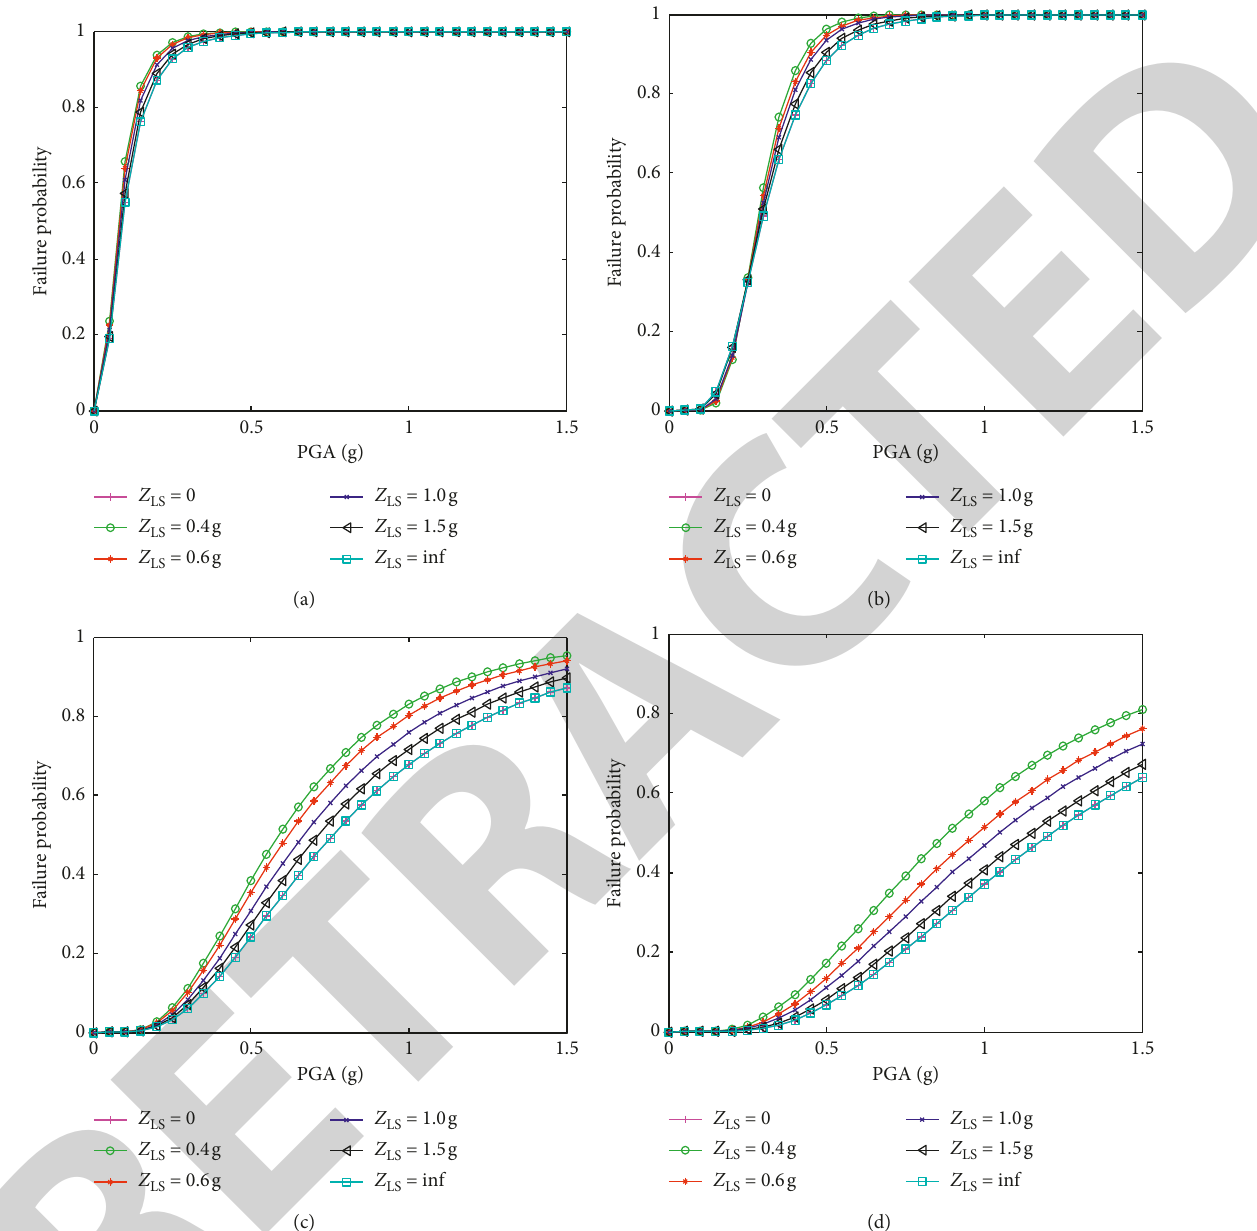
Figure 6: Sensitivity analysis of multidimensional fragility curves to acceleration threshold. (a) Normal operation PLS. (b) Immediate occupancy PLS. (c) Life safety PLS. (d) Collapse prevention